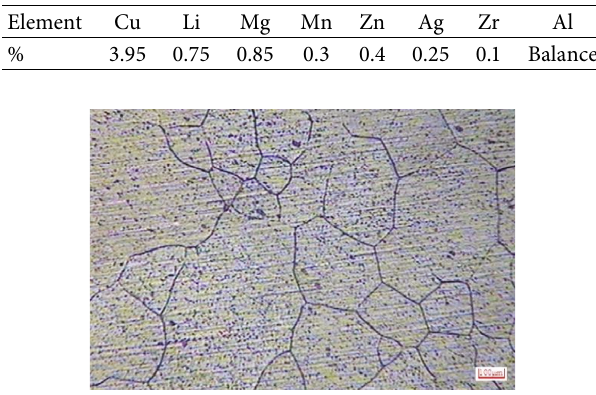
Table 1: Nominal composition of 2060-T8 Al–Li alloy, wt%.